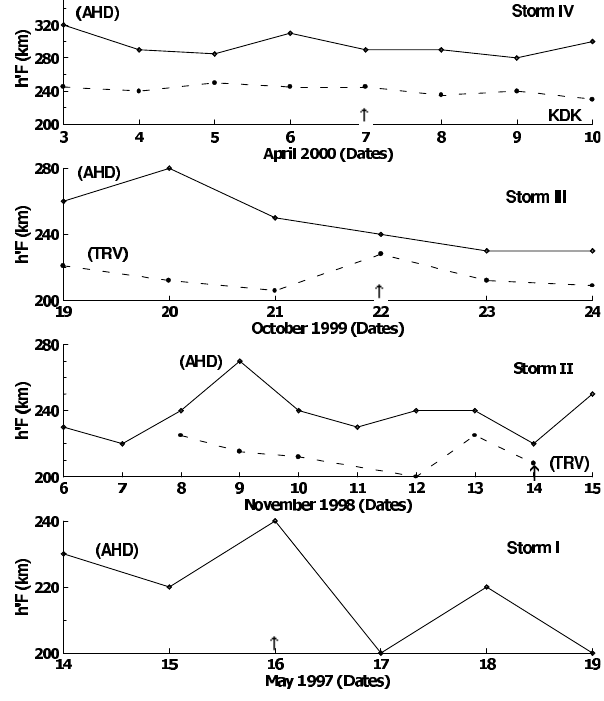
Fig. 7. The figure gives the plots of h 0 F at Ahmedabad (AHD) and at Trivandrum/Kodaikanal (TRV/KDK) during the period of storms I to IV. The latter (TRV/KDK) are the two equatorial stations. The plotted h 0 F values for each day of storm I to storm IV are the mean values corresponding to the local time (IST) interval of the SROSS- C2 pass on the day of the maximum storm effect (i.e. 16 May 1998 for storm I, 14 November 1998 for storm II, 23 October 1999 for storm III and 7 April 2000 for storm IV). The SROSS-C2 satellite pass local time for each day of the storm are given in Table